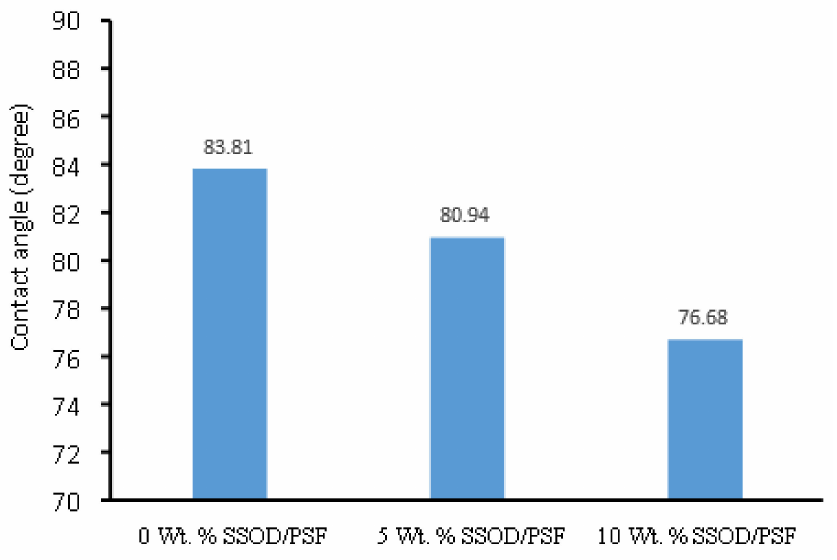
Figure 7. Contact angle